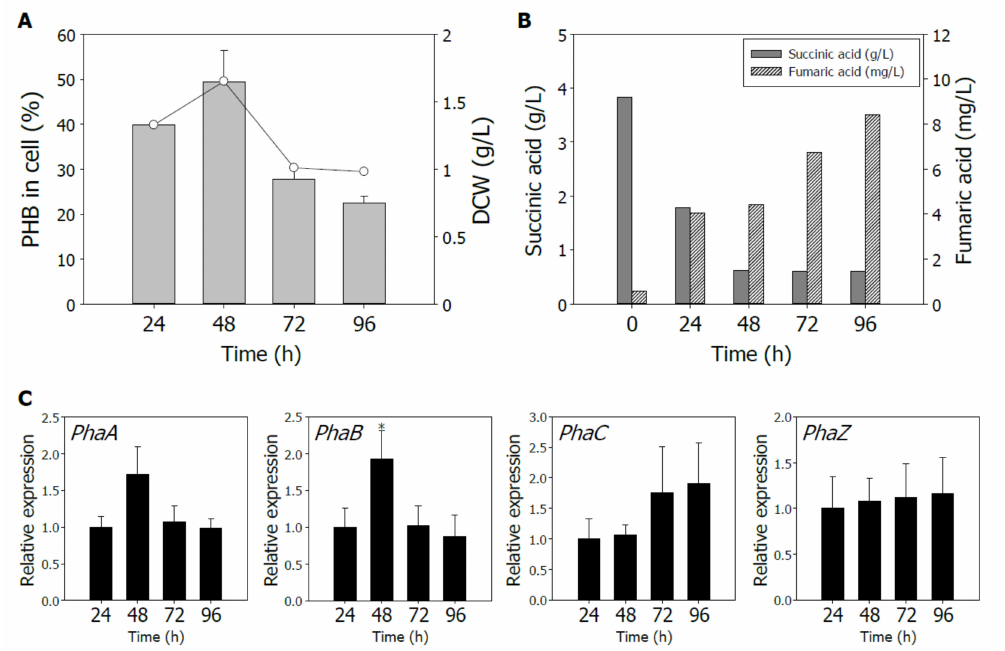
Figure 2. Growth stage-dependent PHB production in R. sphaeroides . ( A ) PHB accumulation (% of dry cell weight) and cell growth. The cells were grown under dark-aerobic conditions and harvested at the indicated time points. Gray bars for PHB contents and open circle lines for DCW. ( B ) Measurement of organic acids concentrations. ( C ) Expression of genes encoding PHB biosynthetic enzymes. Experiments were performed in triplicate and bars indicate standard error of the